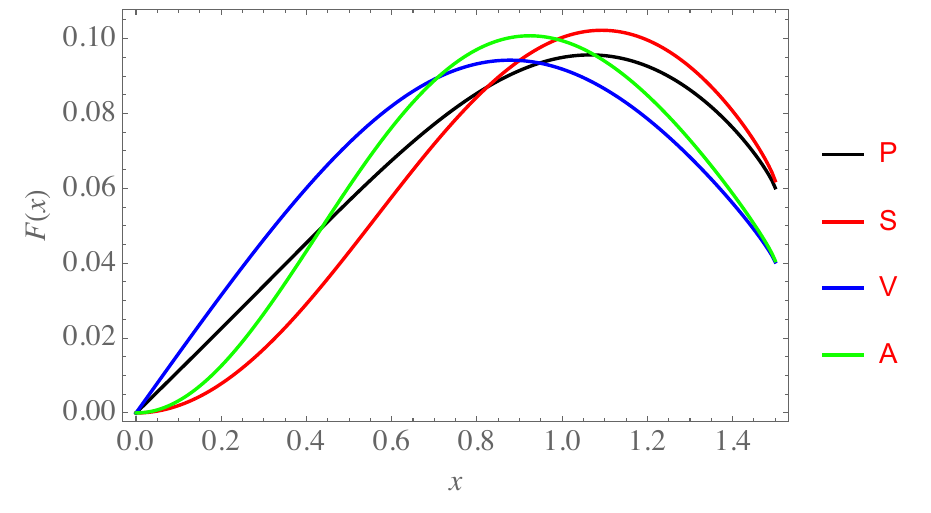
Figure 7 . Form factors for low UV cuto(cid:11) at the critical